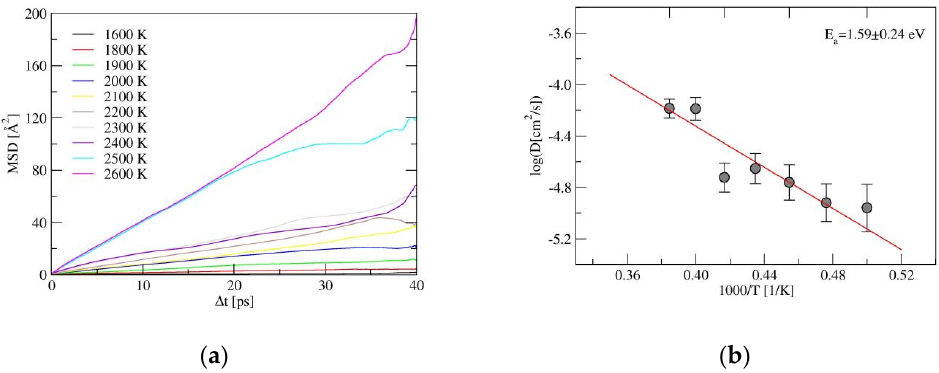
Figure 4. ( a ) The mean-squared-displacements (MSD) for Li + ions simulated by AIMD, and ( b ) the Arrhenius plot of diffusion coefficients for α -LiSiON, from which the Li + ion diffusion energy barrier was obtained, with the error bars of log D given as vertical lines.